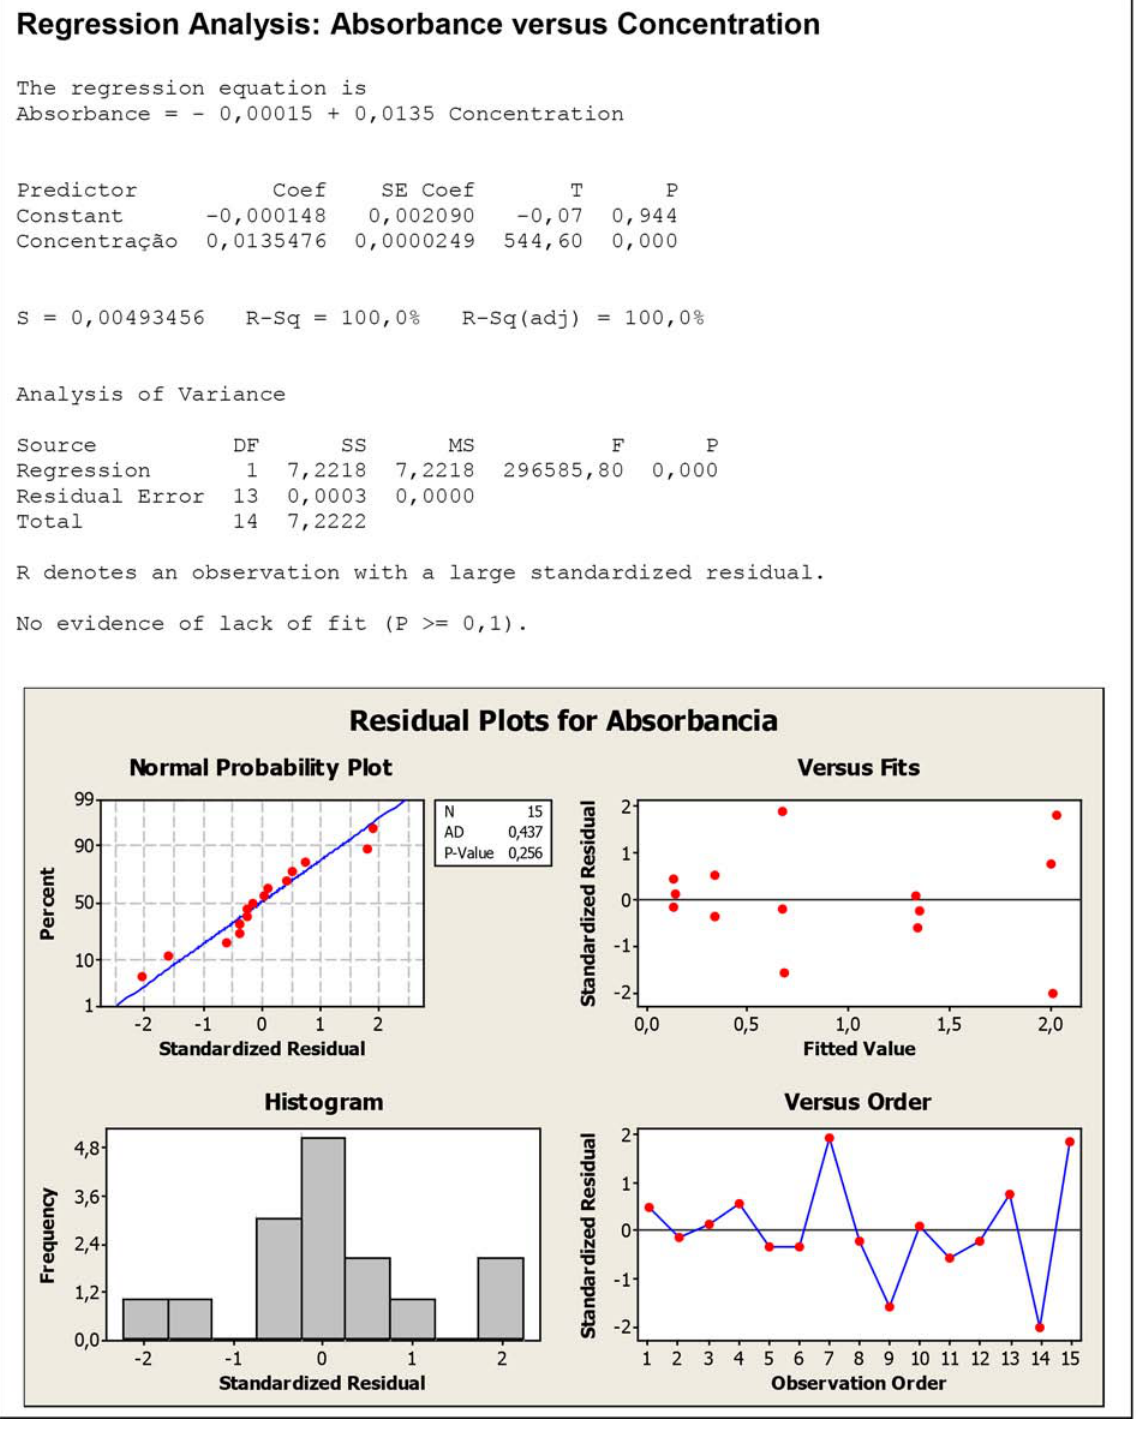
FIGURE 3 - Regression analysis of the results of linearity. of hydrochloric acid in the solvent solution showed no significant impact when this concentration was reduced to 0.4 mol.L-1. However, when the concentration was elevated to 0.8 mol.L -1 the variation became significant